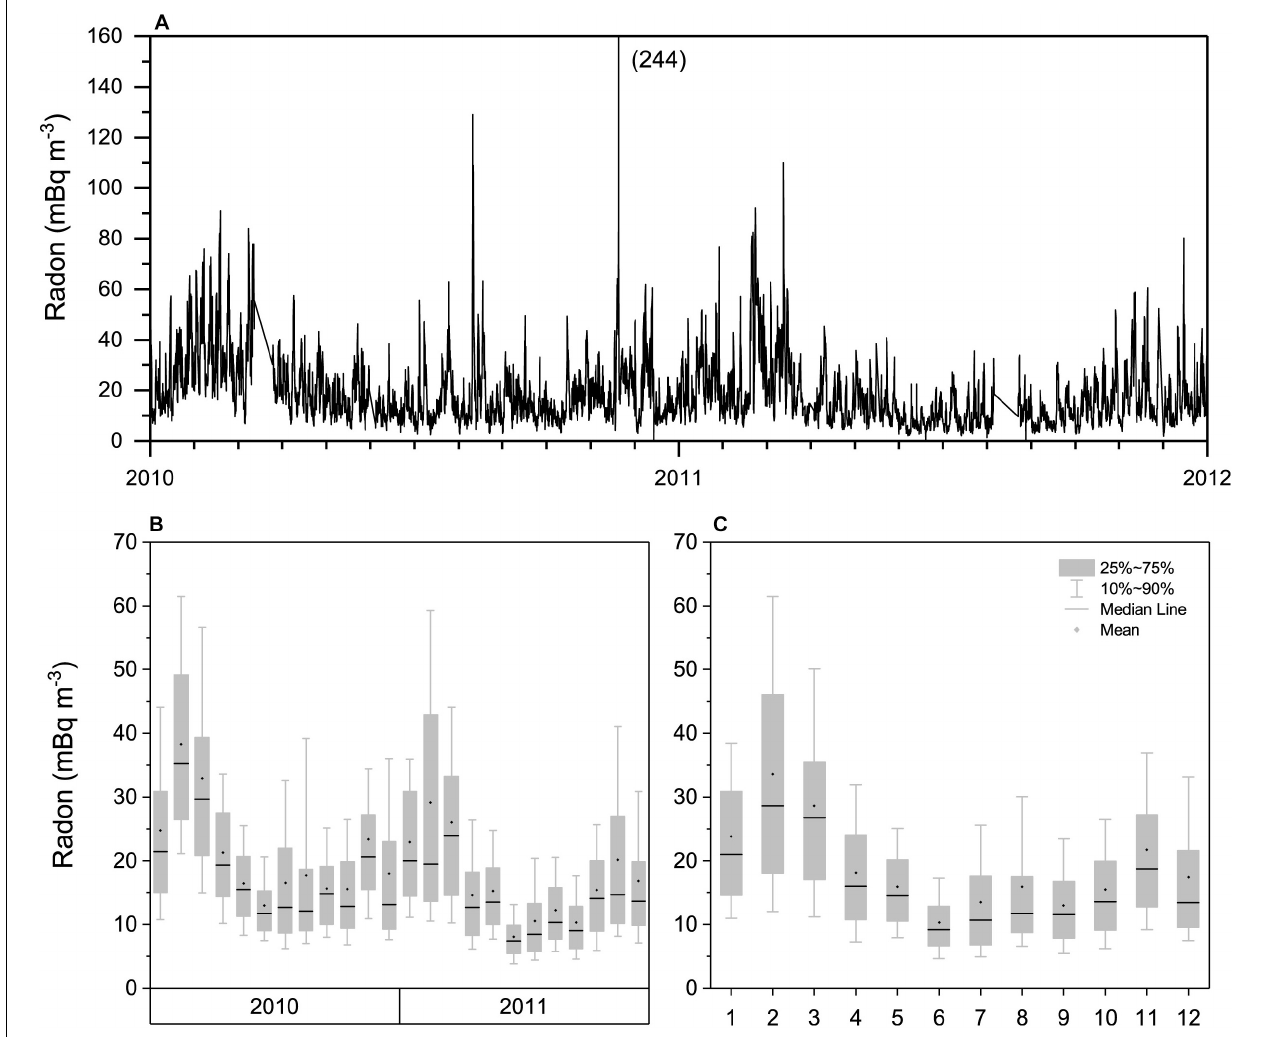
FIGURE 11 | (A) Three-hourly, and (B,C) monthly distributions of NM radon concentrations for 2010 and 2011. Refer to key for distribution box-plot details.